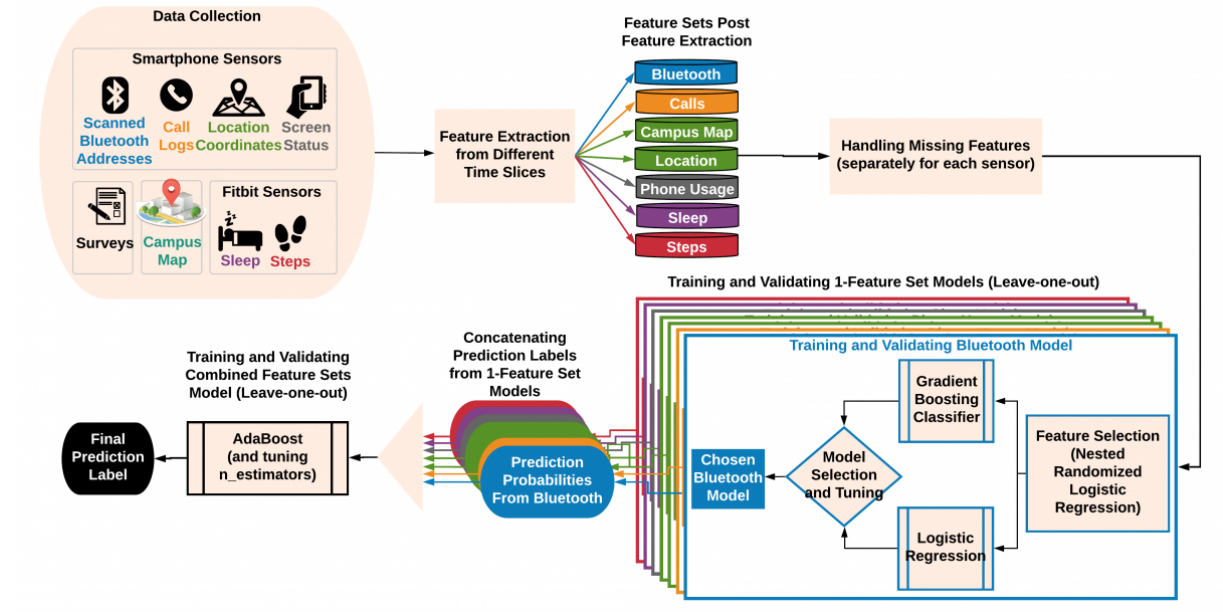
Figure 1. Machine learning pipeline including data collection, feature extraction, training and validation, and final output.